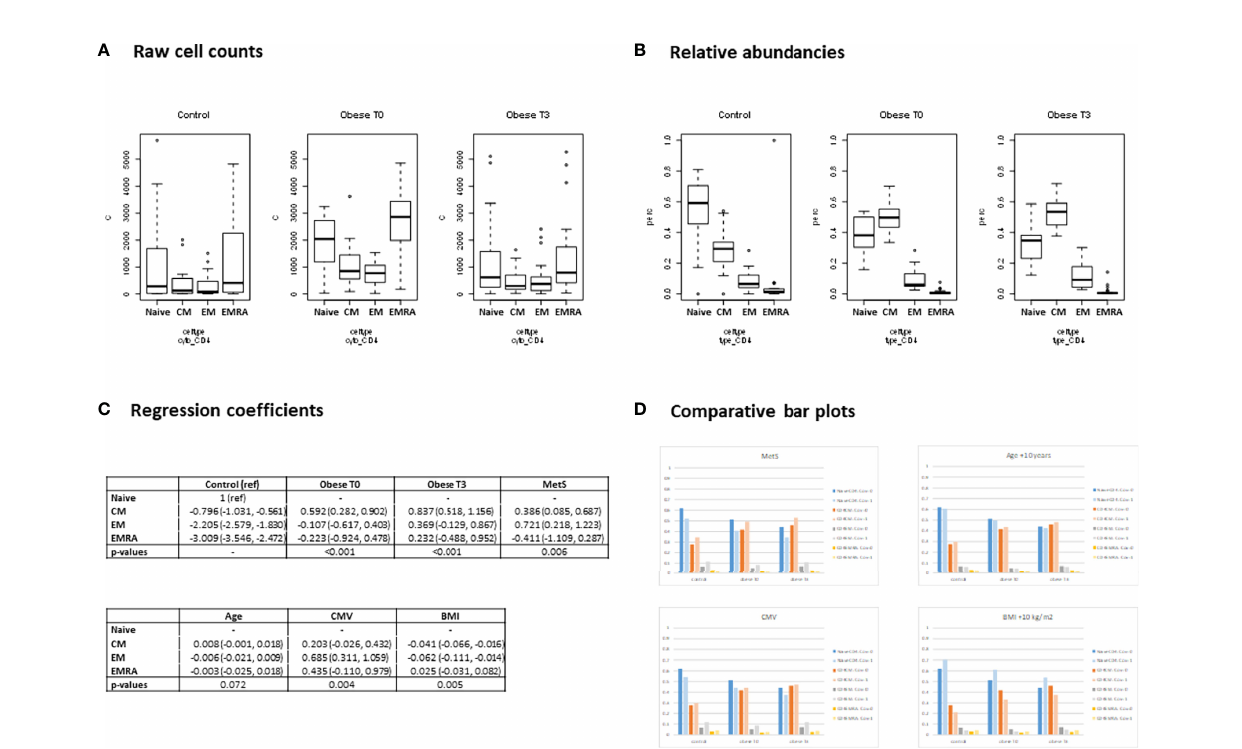
FIGURE 2 | Regression output (Dirichlet multinomial mixed model). CD4 + T cells. (A) Raw cell counts - Boxplots showing the observed distribution of the absolute CD4 + T cell counts for healthy controls, and for morbidly obese patients before (T0), and 3 months after bariatric surgery (T3). The cell counts shown are divided by subtype: Naïve; central memory (CM); effector memory (EM); terminally differentiated effector memory (EMRA). (B) Relative abundancies - Boxplots showing the observed distribution of relative abundancies of the cell subtypes. For each measurement occasion, the 4 subtypes add up to 100%. (C) Coef fi cients - Using the raw cell counts, a Dirichlet Multinomial Mixed model was fi tted modelling the relative abundancies of the cell types. The model was corrected for metabolic syndrome (MetS), Age, CMV status and within group differences in BMI. The regression output is shown here. Coef fi cients may be interpreted as the log of the relative abundancy compared to the reference cell type (Naive CD4+ T cell). The P-values indicate whether a signi fi cant difference in relative abundancy of cell subtypes exists for the morbidly obese patients before and after surgery (Obese T0 and T3) compared to the healthy controls and whether the correcting variables (MetS, Age, CMV and BMI) signi fi cantly affect the relative abundancies. (D) Comparative bar plots - Based on the regression coef fi cients, the expected percentages of the 4 cell types were calculated. For each of the 4 correcting variables, the expected percentages are shown when the covariate is present/high (light colored bars) and absent/average (dark colored bars). When comparing the bar plots to the boxplots of the relative abundancies of the raw data, ( Figure 2B ), it can be observed that pattern of the expected percentages based on the model resembles that of the (unadjusted) observed percentages (which is to be expected if the model adequately describes the